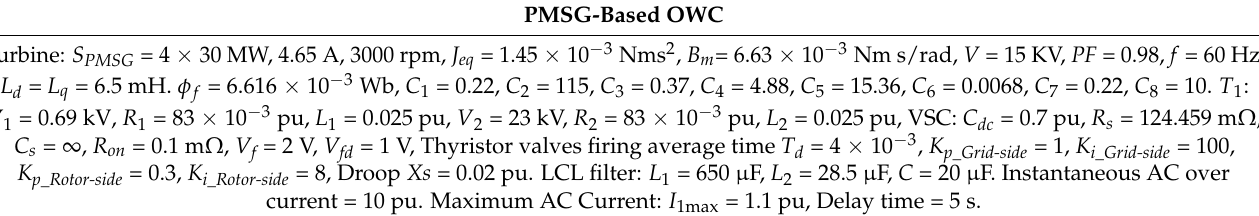
Table A1. Simulation parameters of PMSG-based OWC. PMSG-Based